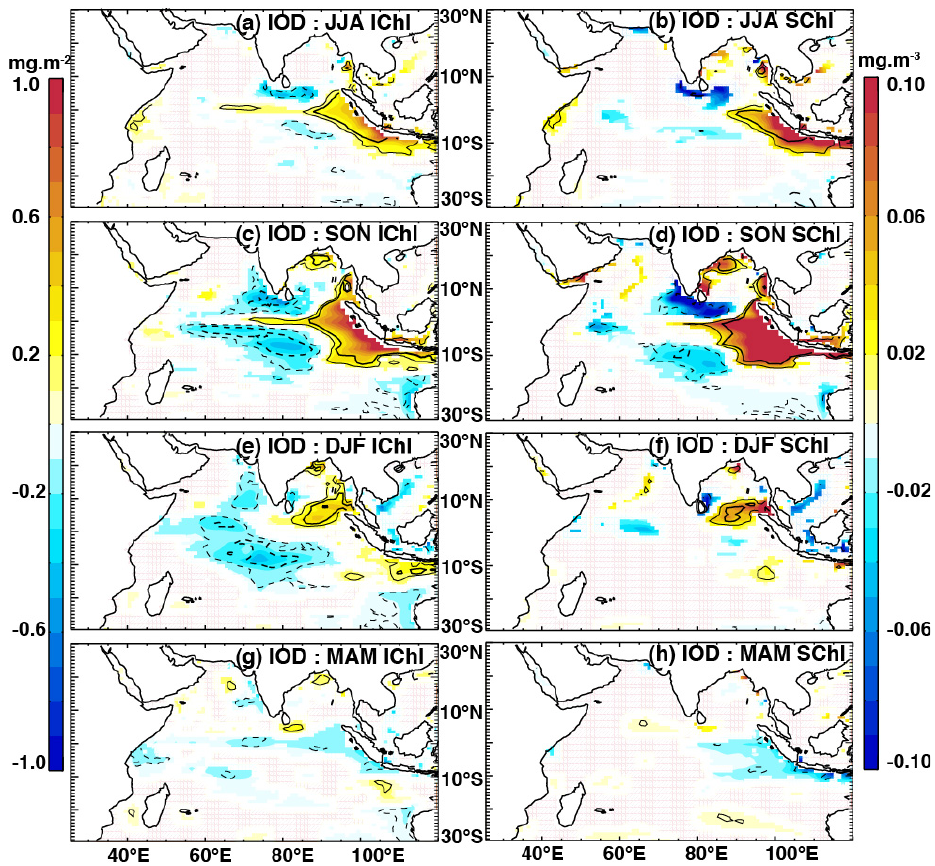
Fig. 7. The impacts of IOD on I Chl (left panels) and S Chl (right panels), as indicated by partial regression coefficients of their anomalies regressed onto the IOD index, having removed the influence of ENSO (Eqs. 1–3). Regressions were computed for the period 1961–2001 and their coefficients were drawn only when beyond a 90% significance level. Thin and thick contours indicate correlation coefficients of 0.4 and 0.6 respectively, while solid (dashed) lines represent positive (negative)